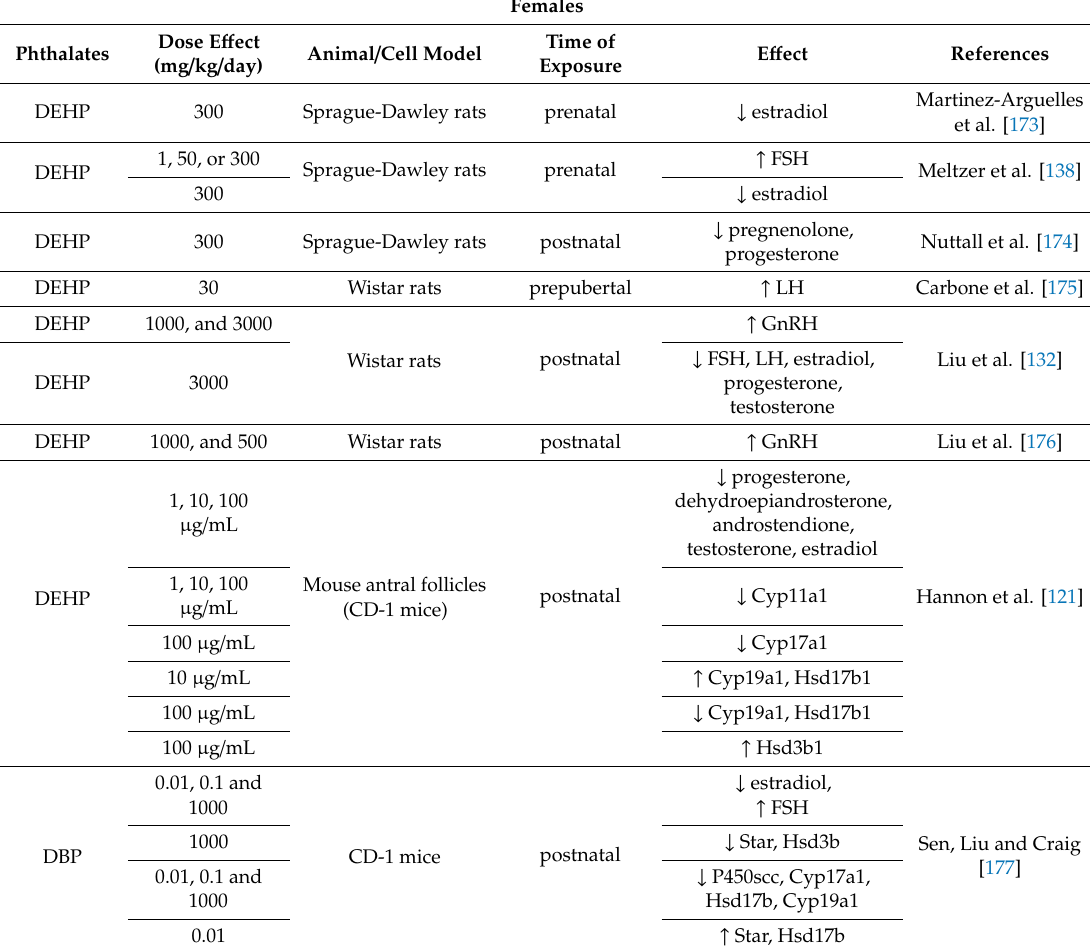
Table 3. Phthalates e ff ect on hypothalamic–pituitary–gonadal (HPG) axis and steroidogenesis (in vivo, in vitro